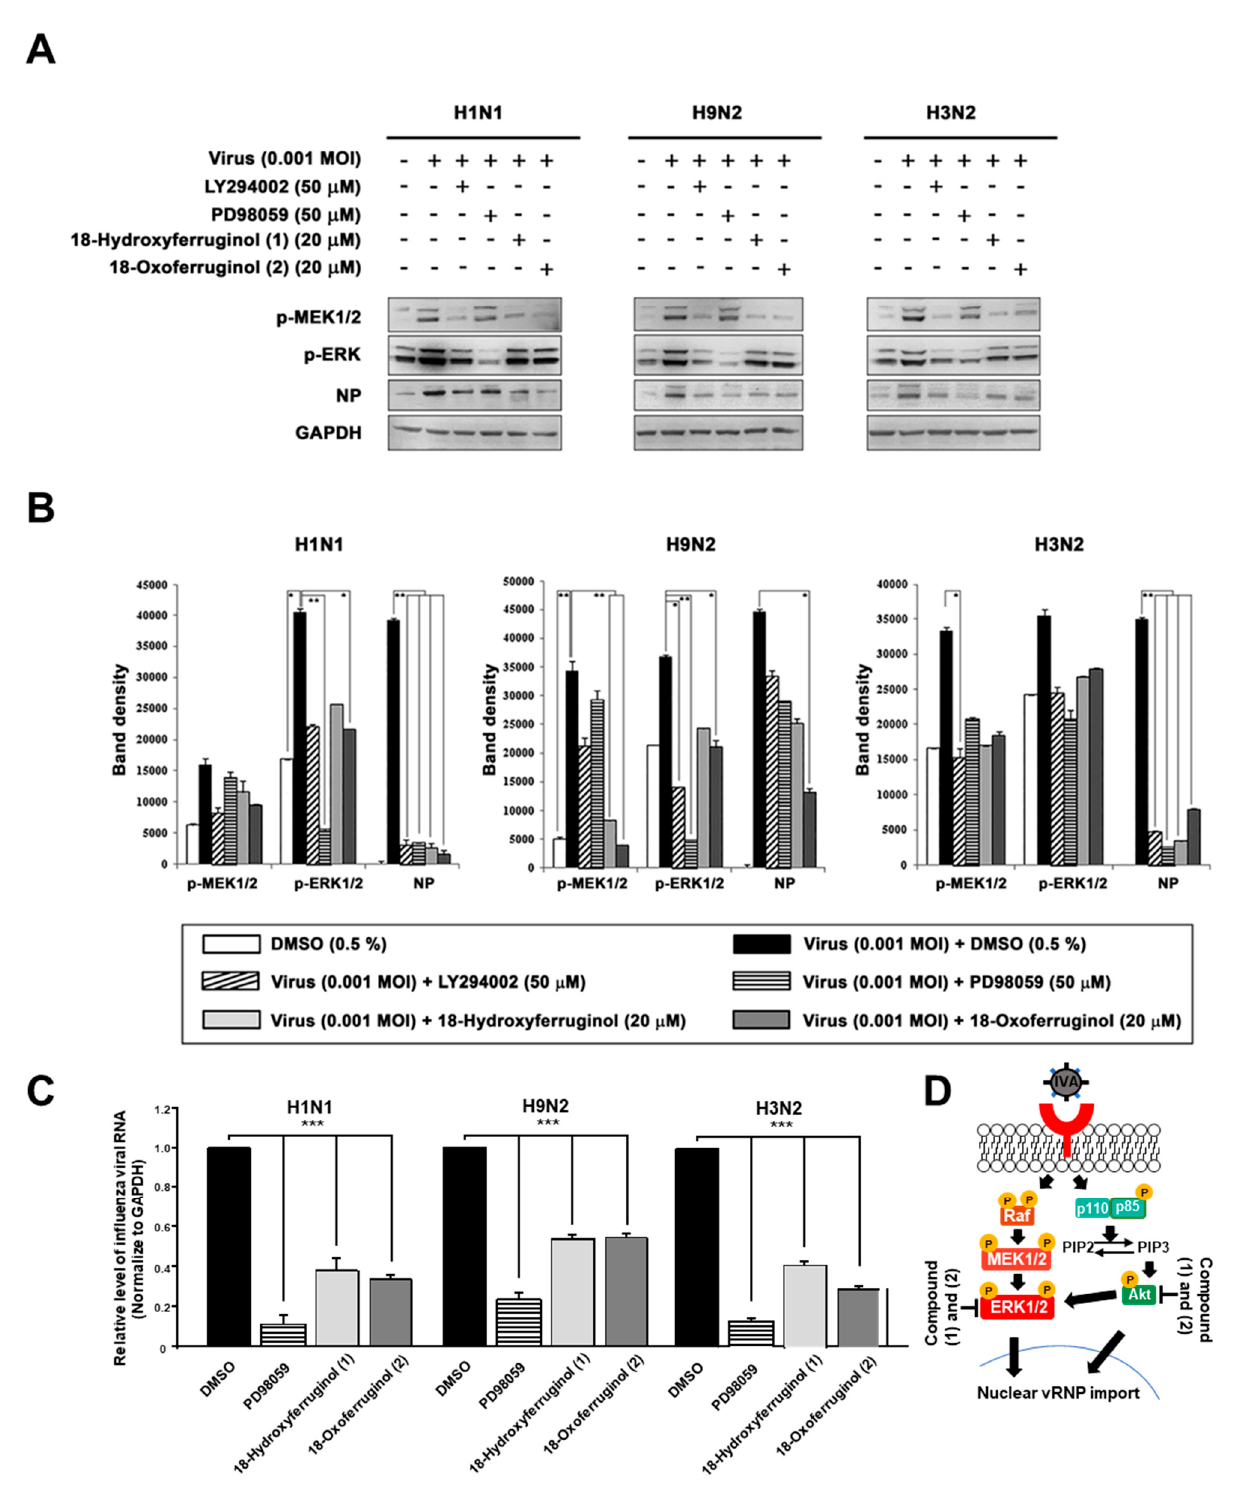
Figure 4. 18-Hydroxyferruginol ( 1 ) and 18-oxoferruginol ( 2 ) inhibit influenza-virus-induced ERK phosphorylation. MDCK cells were infected with H1N1, H9N2, or H3N2 at 0.001 MOI for 1 h and incubated with DMSO (0.5%), LY294002 (50 μ M), PD98059 (50 μ M), 18-hydroxyferruginol ( 1 ) (20 μ M), or 18-oxoferruginol ( 2 ) (20 μ M) for 10 h. ( A ) p-MEK1/2, p-ERK, and NP levels were measured by Western blot analysis. ( B ) The band density was quantified by using ImageJ software. Phosphorylated ERK1/2, MEK1/2, and NP protein accumulations were normalized by the GAPDH level. ( C ) After infecting them with influenza viruses, MDCK cells were treated with 50 μ M PD98059, 20 μ M 18-hydroxyferruginol ( 1 ), or 20 μ M 18-oxoferruginol ( 2 ). Total RNA was extracted 10 h after